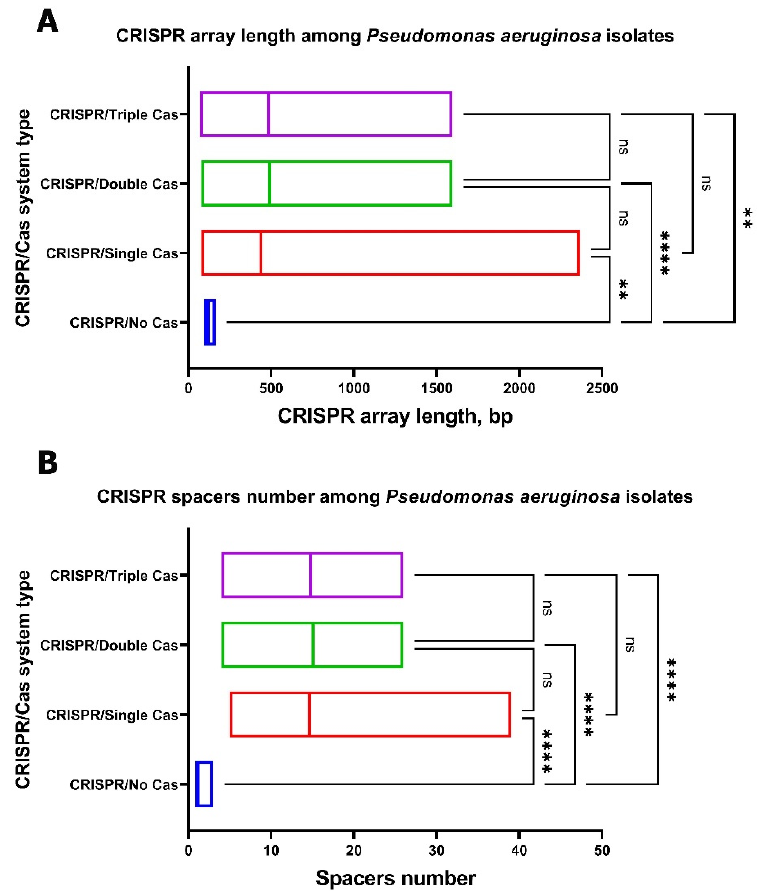
Figure 8. CRISPR array length ( A ) and spacers count ( B ) among CriePir P. aeruginosa isolates. ** and **** indicate the increasing levels of significance p < 0.01 and p < 0.0001, respectively.